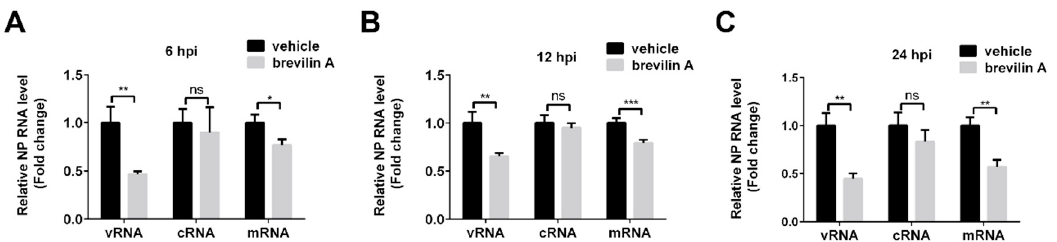
Figure 4. The inhibitory effects of brevilin A on the expression of virus RNA. MDCK cells were infected with PR8 at a MOI of 1, then treated with brevilin A or vehicle. Total RNA was extracted at 6 hpi ( A ), 12 hpi ( B ), or 24 hpi ( C ), and the vRNA, cRNA, and mRNA were quantified by RT-qPCR. *, p < 0.05; **, p < 0.01; ***, and p < 0.001 are considered statistically significant, compared to vehicle.